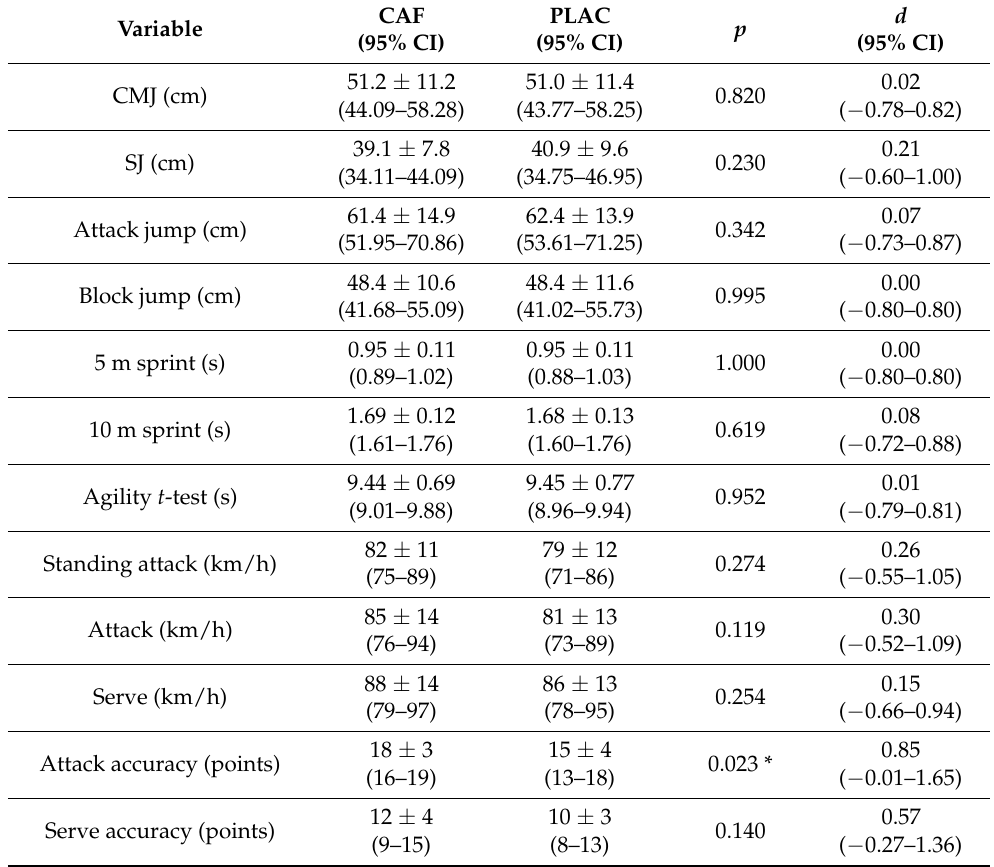
Table 1. Comparison of the caffeinated chewing gum (~3.2 mg/kg of caffeine) and non-caffeinated chewing gum (placebo) trial in volleyball-specific skills and physical performance